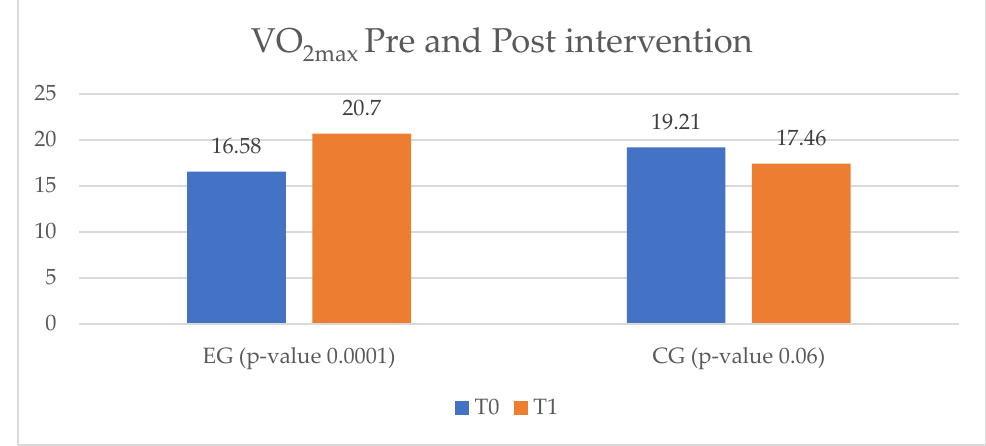
Figure 7. VO 2max pre- and post-intervention. VO 2max = maximal oxygen consumption by the body (measured in mL/kg/min); EG = experimental group; CG = control group; T 0 = before the rehabilitation period; T 1 = after the rehabilitation period.